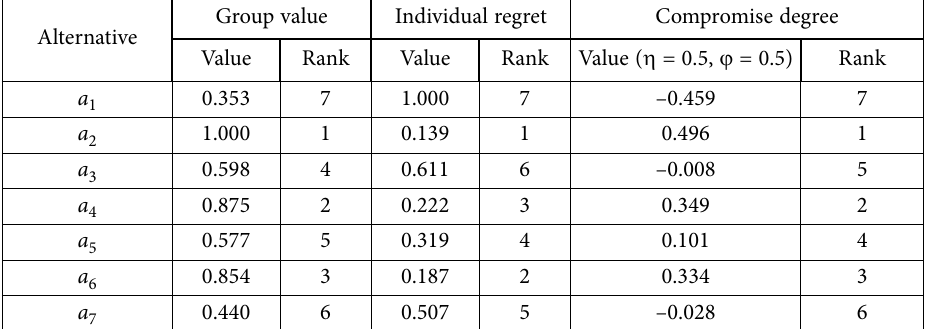
Table 5. The group values and individual regrets of alternatives obtained by the proposed method